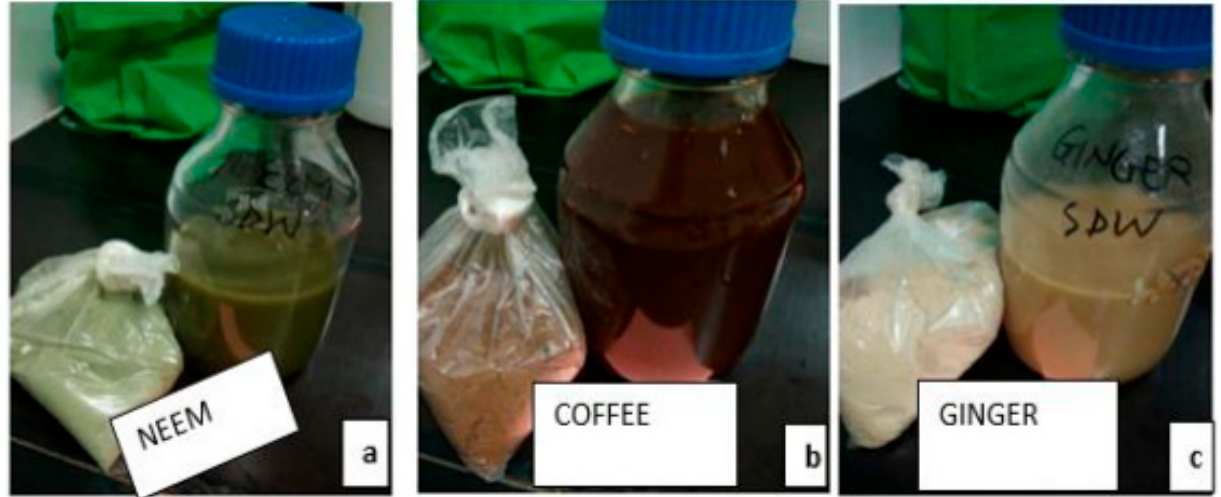
Figure 2. Plant extracts in powdery form (in plastic bags) and extracts dissolved in sterile distilled water (in glass bottles); the bio-fungicides. ( a ) Water-extracted neem; ( b ) water-extracted coffee; ( c ) water-extracted ginger.